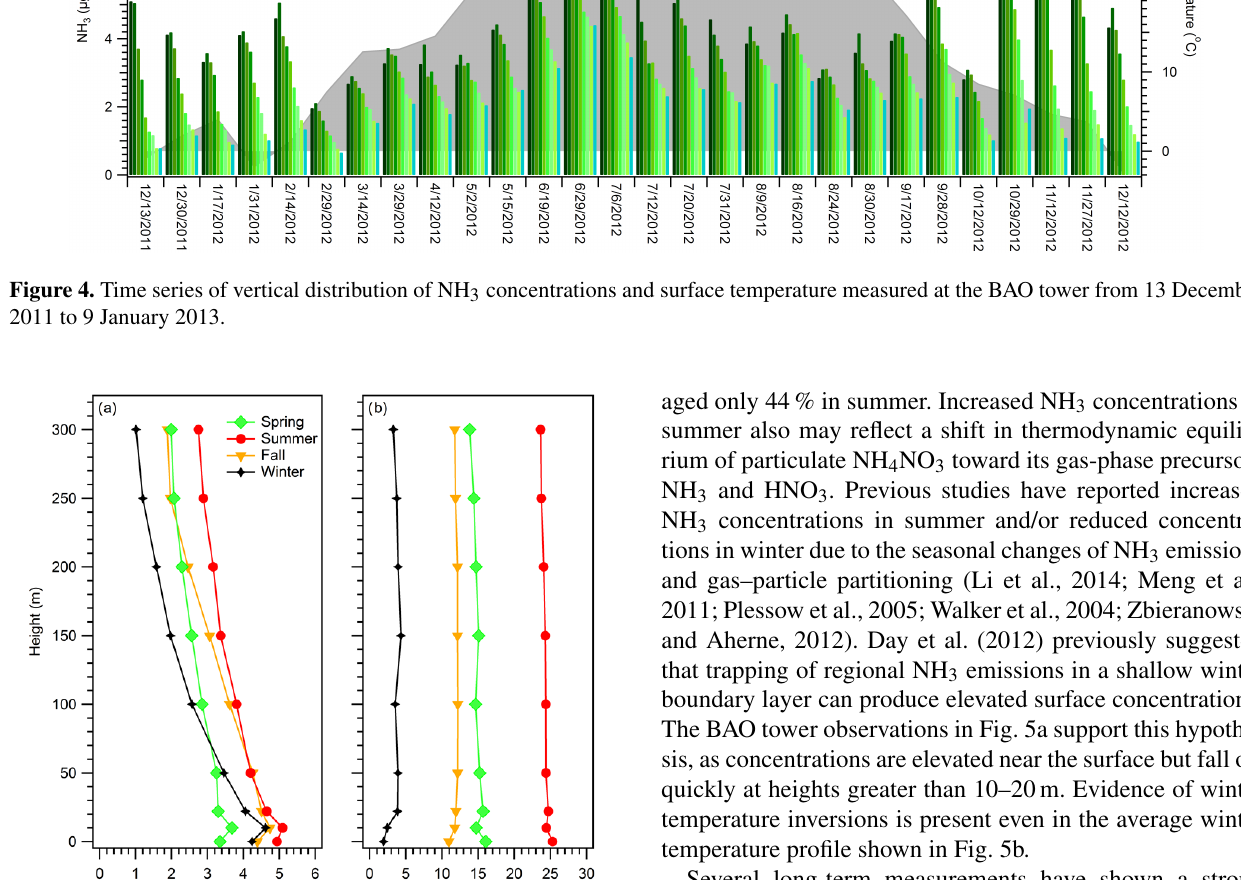
spring; June, July, and August as summer; September,